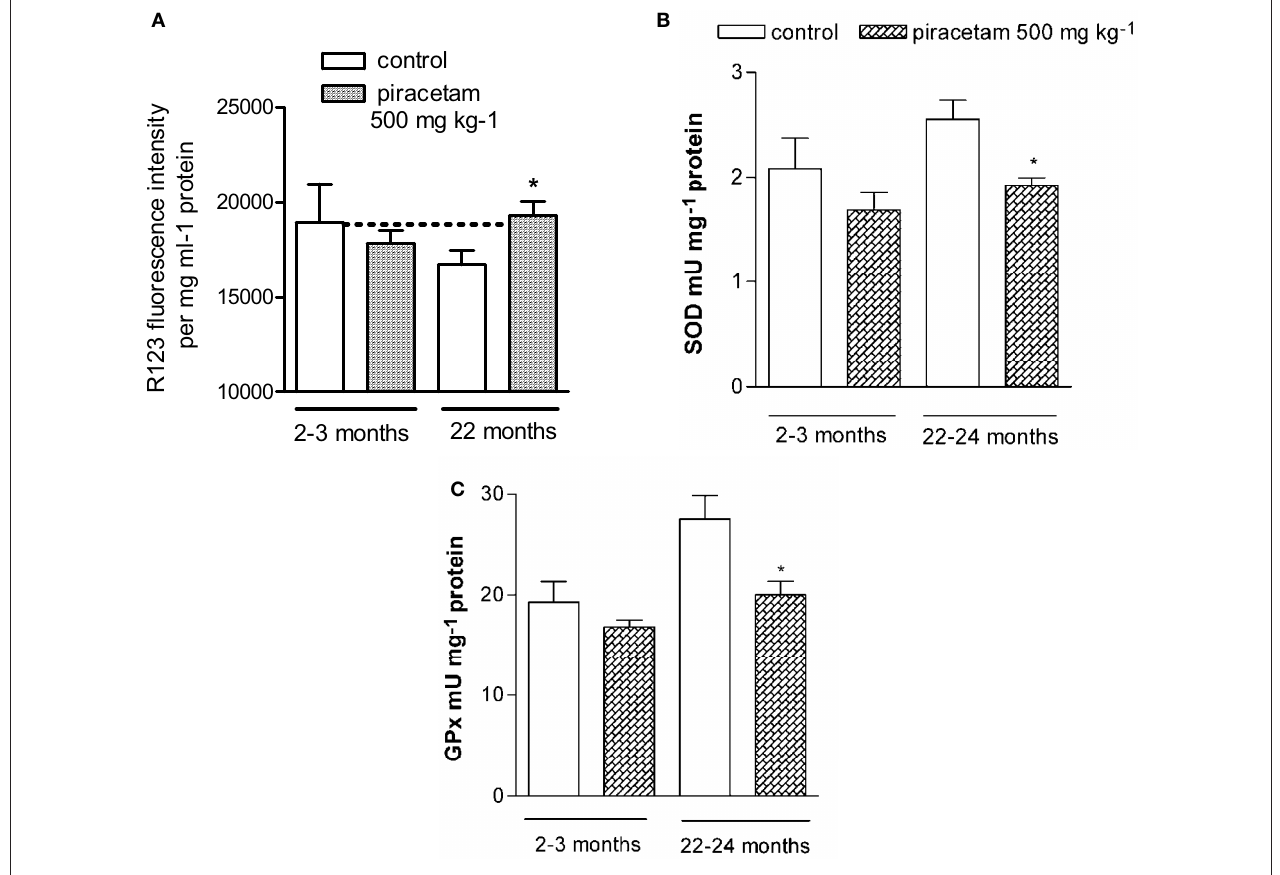
(22 months) and protected by Piracetam. Data are expressed as mean ± SEM ( n = 6–8) * p < 0.05 piracetam treated old animals vs. aged controls. (B,C) Effects of aging and treatment with piracetam on SOD, and GPx in young and old animals. Activities of antioxidant enzymes are increased in aged mice. Treatment with piracetam reduces the enzyme activities significantly in old mice. Data are expressed as mean ± SEM ( n = 7). * p < 0.05 piracetam treated old animals vs. aged